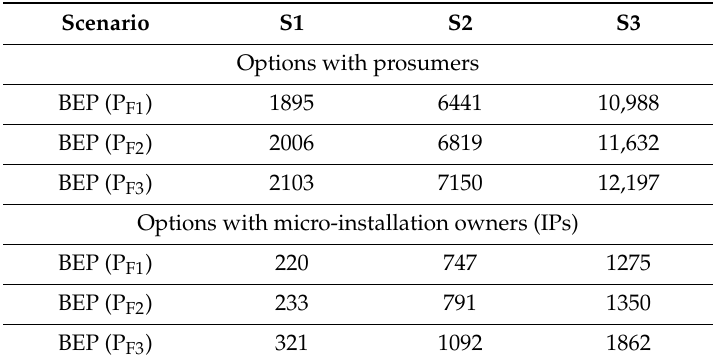
Table 3. Break-even point (BEP): Number of prosumers or IPs joined to the distribution grids that allow achieving nonprofit financial result (cost =